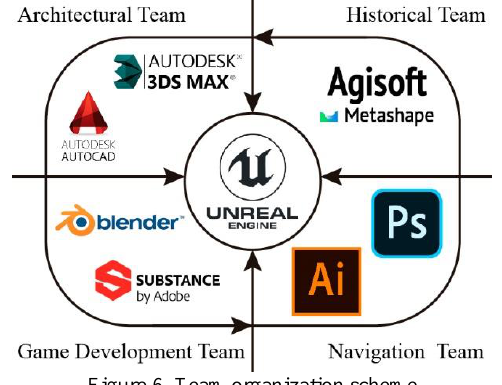
Figure 6 . Team organization scheme